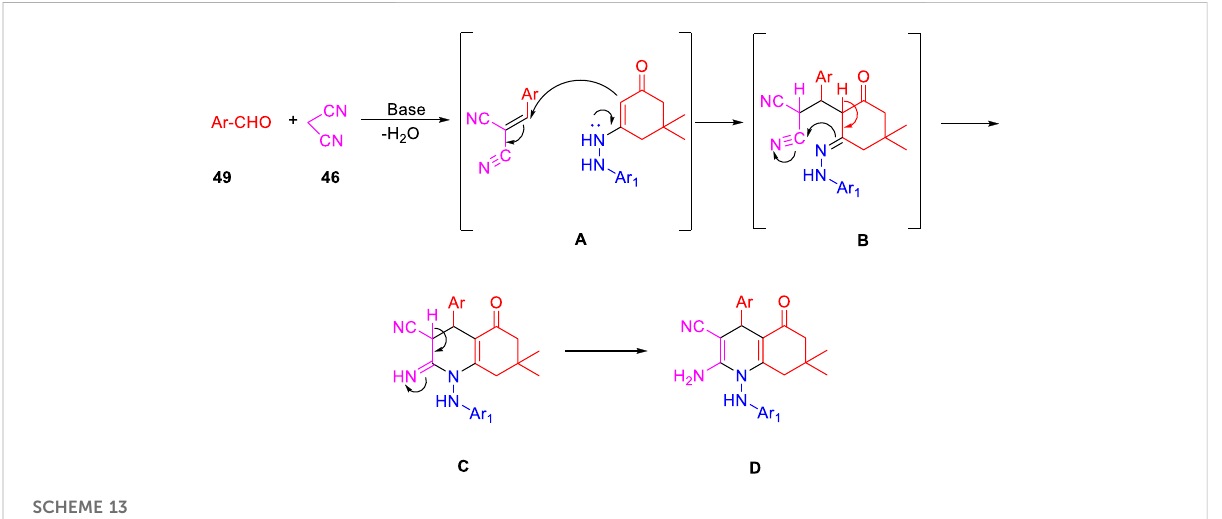
SCHEME 13 Plausible mechanism for the synthesis of polyhydroquinoline derivatives.